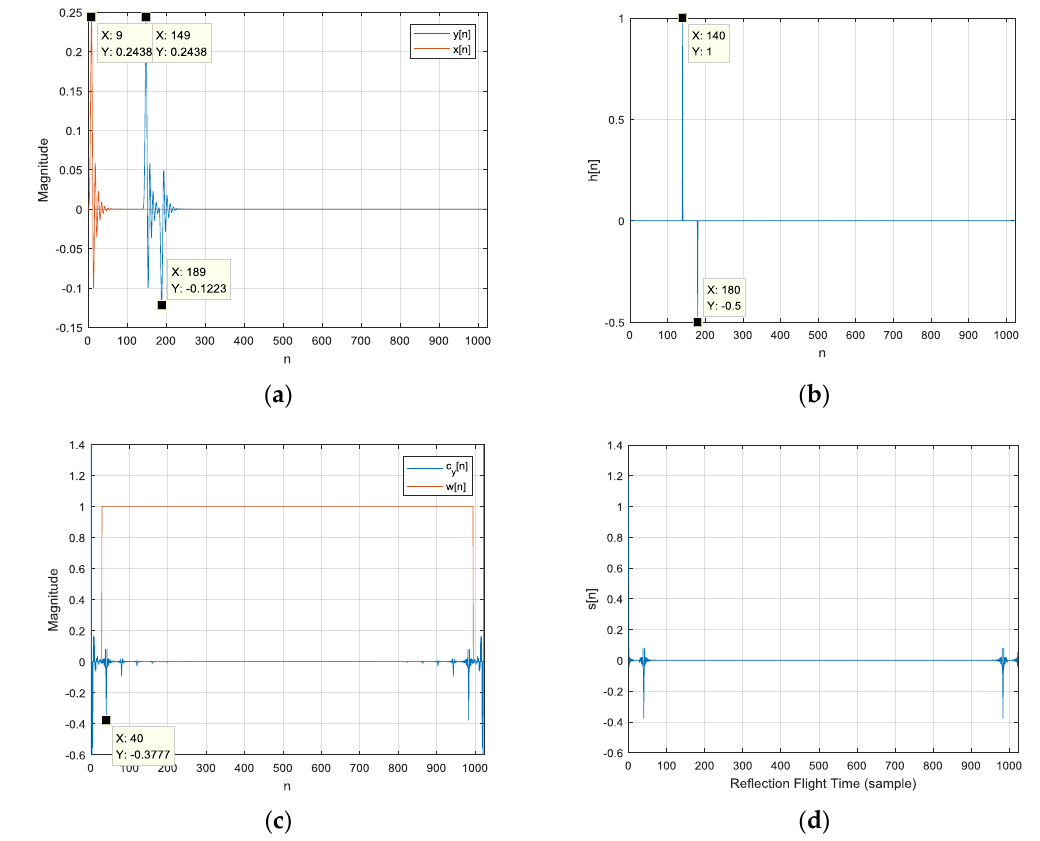
Figure A1. Homomorphic deconvolution for low-frequency signal based on the impulse response of the Butterworth filter (BW: 0.25). ( a ) Sound source x [ n ] and received signal y [ n ]; ( b ) impulse response of propagation; ( c ) real cepstrum output c y [ n ] and window function w [ n ]; and ( d ) the output of the homomorphic deconvolution as ˆ s [ n ] .